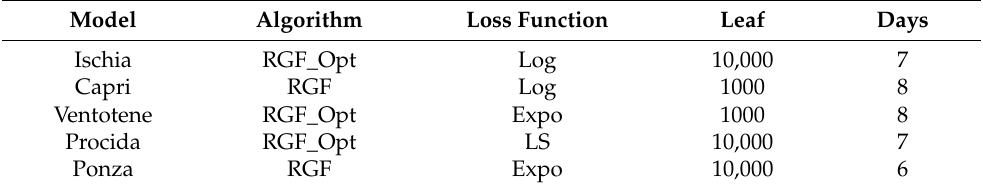
Table 4. Optimum Configuration.